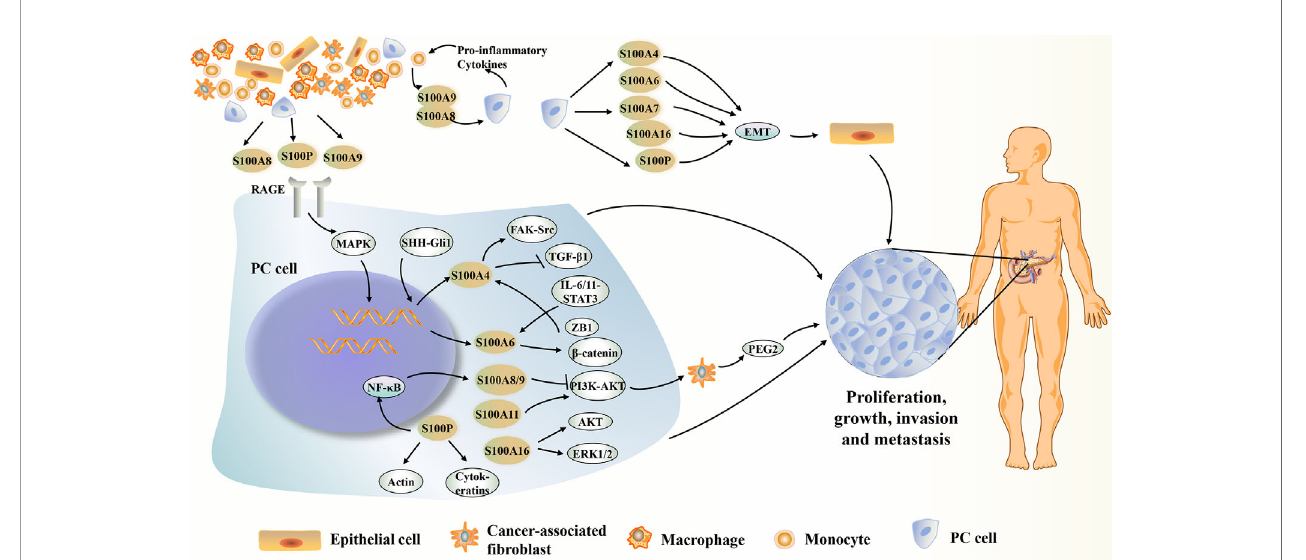
FIGURE 1 | Summary of the potential mechanisms of several S100 proteins affecting PC. S100 proteins present in or derived from PC cells and surrounding stromal cells can play an important intracellular and extracellular role in the PC development. S100A4, S100A6, S100A7, S100A8, S100A9, S100A10, S00A11, S10016 and S100P show increased expression during PC development. They can act on certain proteins or signaling pathways inside or outside the cell, directly or indirectly affecting the growth, proliferation, metastasis or invasion of PC. However, S00A14 can inhibit PC metastasis or apoptosis of PC cells. EMT, epithelial- mesenchymal transition; ERK1/2, extracellular signal-regulated kinase 1/2; FAK, focal adhesion kinase; IL-6/11, interleukin-6/11; MAPK, mitogen-activated protein kinase; NF- k B, nuclear factor kappa-light-chain-enhancer of activated B cells; PEG2, prostaglandin E2; PI3K/AKT, phosphatidylinositol-3-kinase (PI3K)/protein kinase B (AKT); RAGE, advanced glycosylation end-product receptor; STAT3, signal transducer and activator of transcription 3; TGF- b 1, transforming growth factor